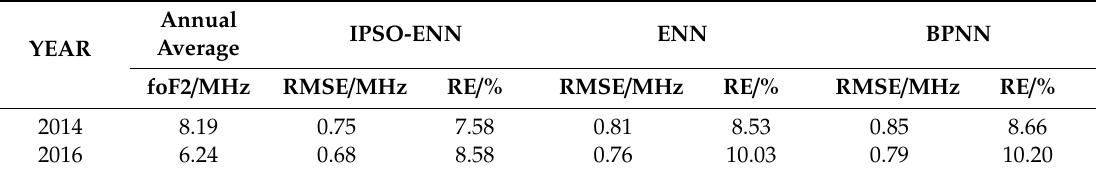
Table 2. Forecast error. IPSO: improved particle swarm optimization; ENN: Elman neural network; BPNN: back-propagation neural network.